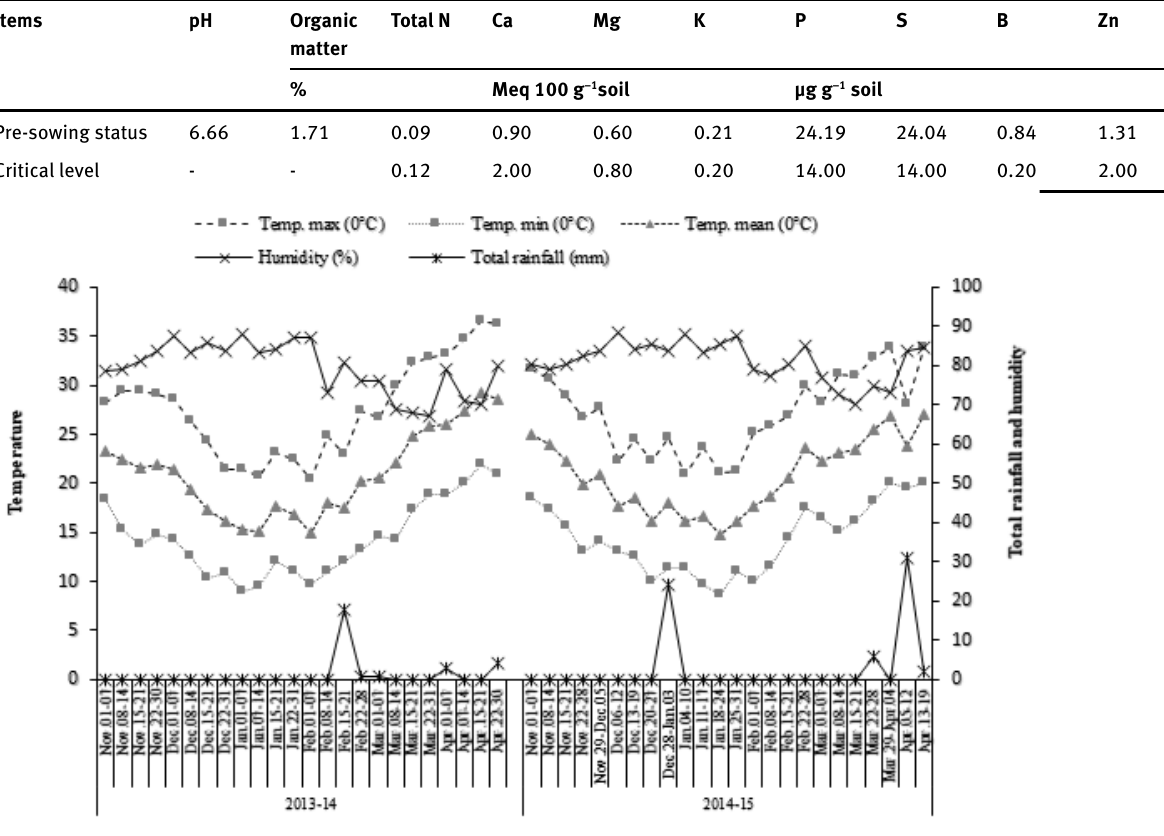
Table 1: Soil analysis report of the experimental field before sowing Items pH Organic